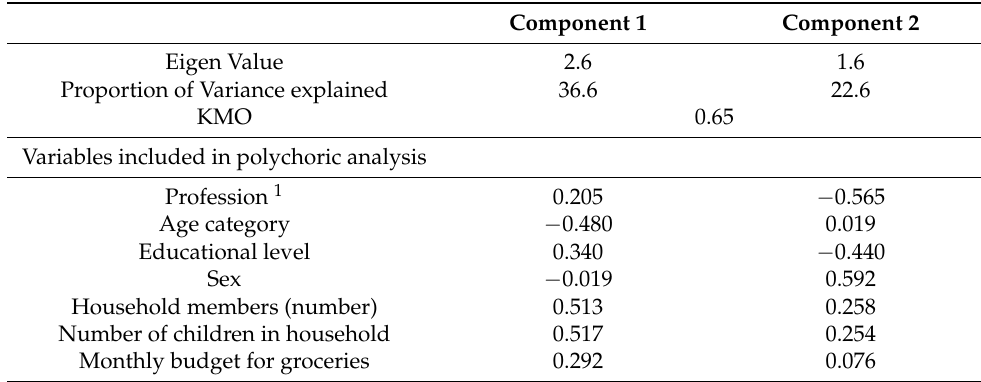
Table 3. Consumer profile characteristics following polychoric analysis. Principal components (Eigen vectors) (blanks are abs (loading)